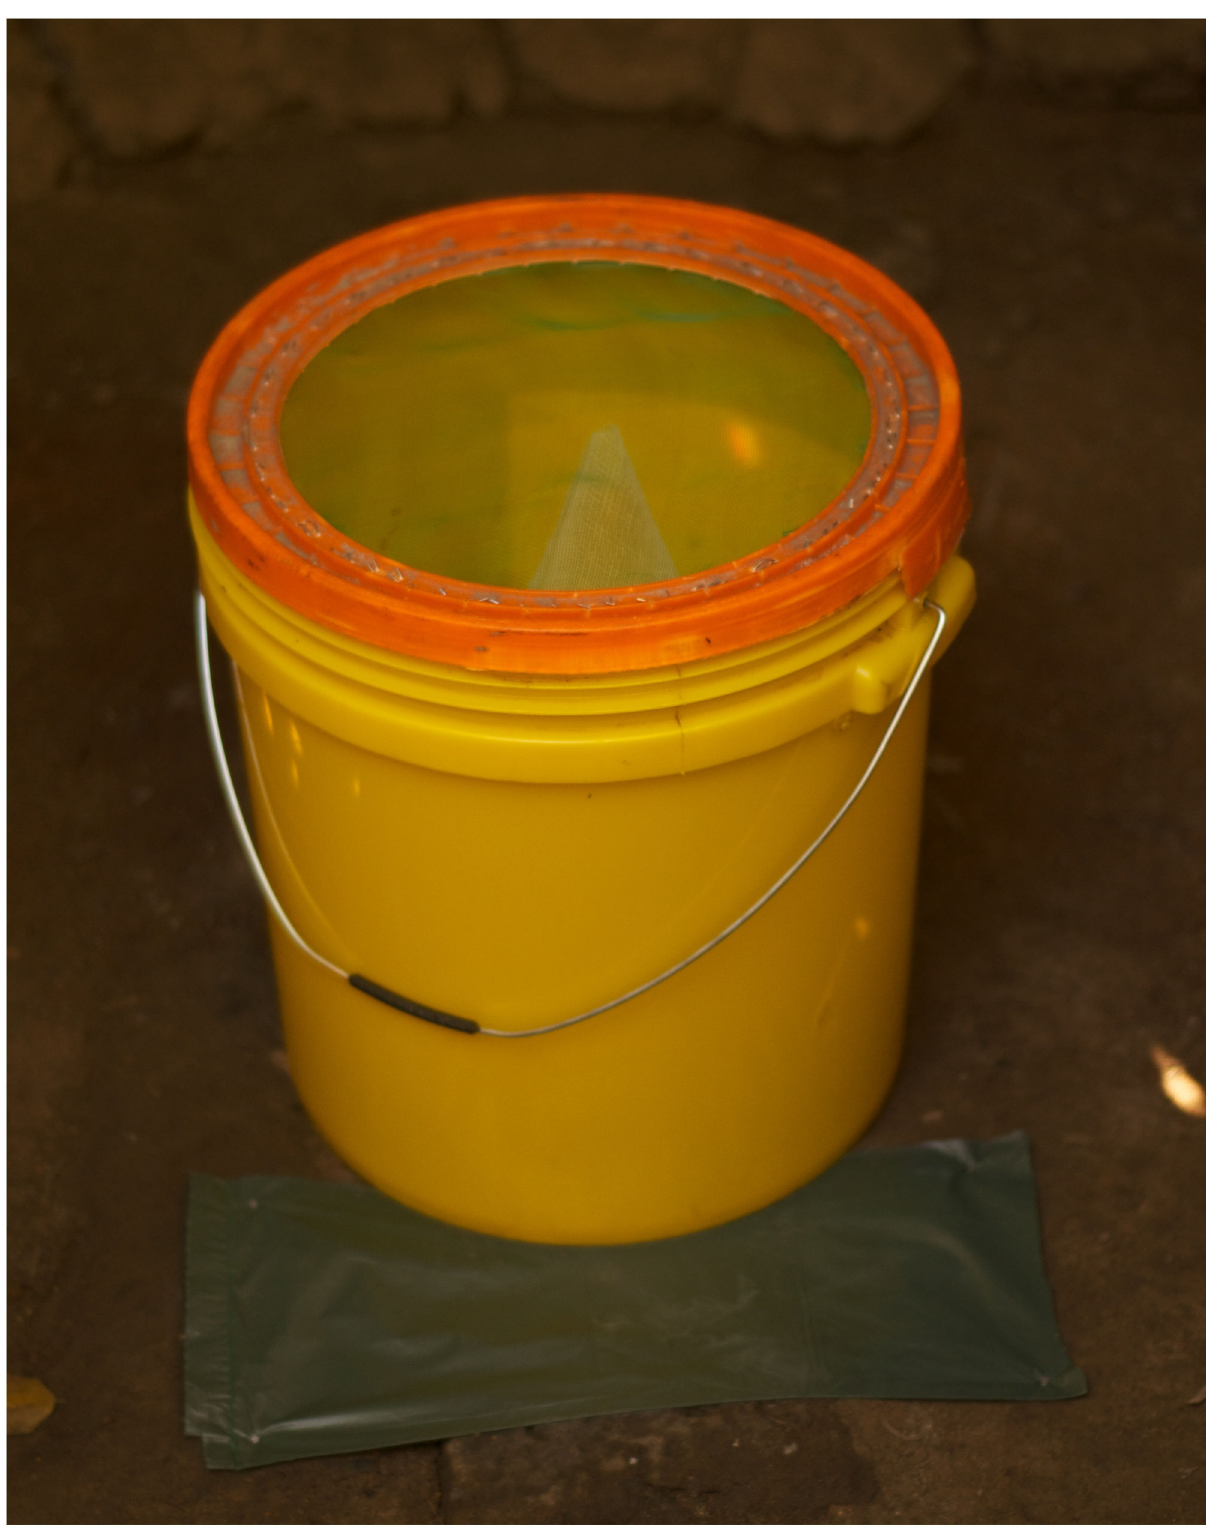
Figure 1. Drop-hole modification and trap placement.